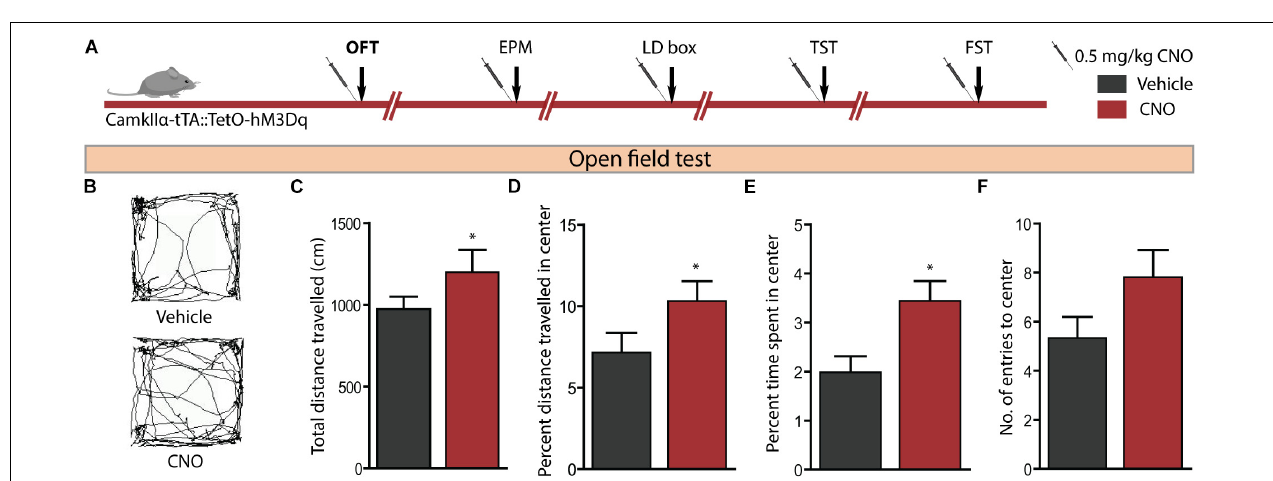
FIGURE 1 | hM3Dq and hM4Di DREADD-mediated activation and inhibition of CamKII α -positive forebrain excitatory neurons. (A) Shown is a schematic of the genetic strategy used to create bigenic CamKII α -tTA:TetO-hM3Dq and CamKII α -tTA:TetO-hM4Di mice to drive expression of the hM3Dq and hM4Di DREADD in forebrain CamKII α -positive excitatory neurons respectively. (B) Shown is protein expression of the HA antigen in the forebrain circuits of the cortex (Ctx) and the hippocampus (Hpc) confirming expression of the HA-tagged hM3Dq (HA-hM3Dq) and hM4Di (HA-hM4Di) DREADD. (C) Shown is a schematic of the experimental paradigm used to confirm the activation of the hM3Dq DREADD in the forebrain. (D) Western blotting analysis revealed that adult bigenic CamKII α -tTA:TetO-hM3Dq mice injected with CNO (0.5 mg/kg) showed significant induction in c-Fos protein expression in the hippocampus ( n = 4/group), and a trend toward an increase in the cortex. (E) Immunohistochemical analysis indicated that acute CNO-mediated hM3Dq DREADD activation resulted in a significant increase in the number of c-Fos positive cells in the hippocampal subfields, namely the Dentate gyrus (DG), CA3, and CA1 ( n = 9–10/group). (F) Shown is a schematic of the experimental paradigm used to confirm the activation of the hM4Di DREADD in the forebrain. (G) Western blotting analysis revealed that adult bigenic CamKII α -tTA:TetO-hM4Di mice injected with CNO (0.5 mg/kg) showed a significant decline in c-Fos protein expression in the hippocampus ( n = 4/group), and no change in c-Fos protein levels in the cortex. Results are expressed as the mean ± SEM, ∗ p < 0.05, $ p = 0.07, as compared to vehicle-treated control mice using the two-tailed, unpaired Student’s t -test.